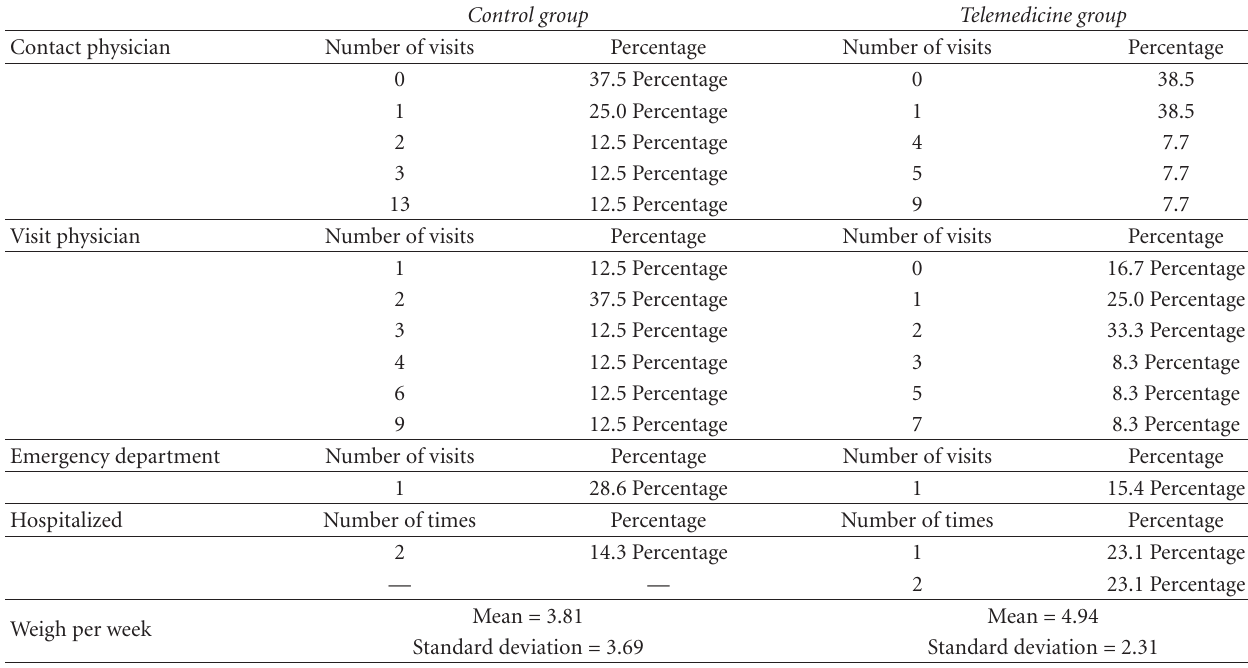
Table 3: Control and telemedicine patient utilization of healthcare